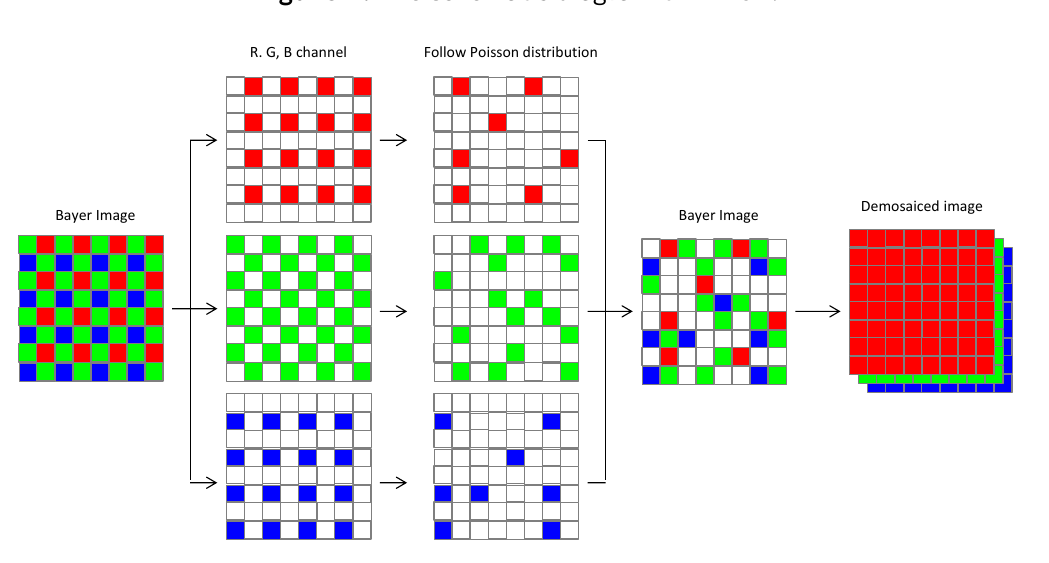
Figure 2. The schematic diagram of